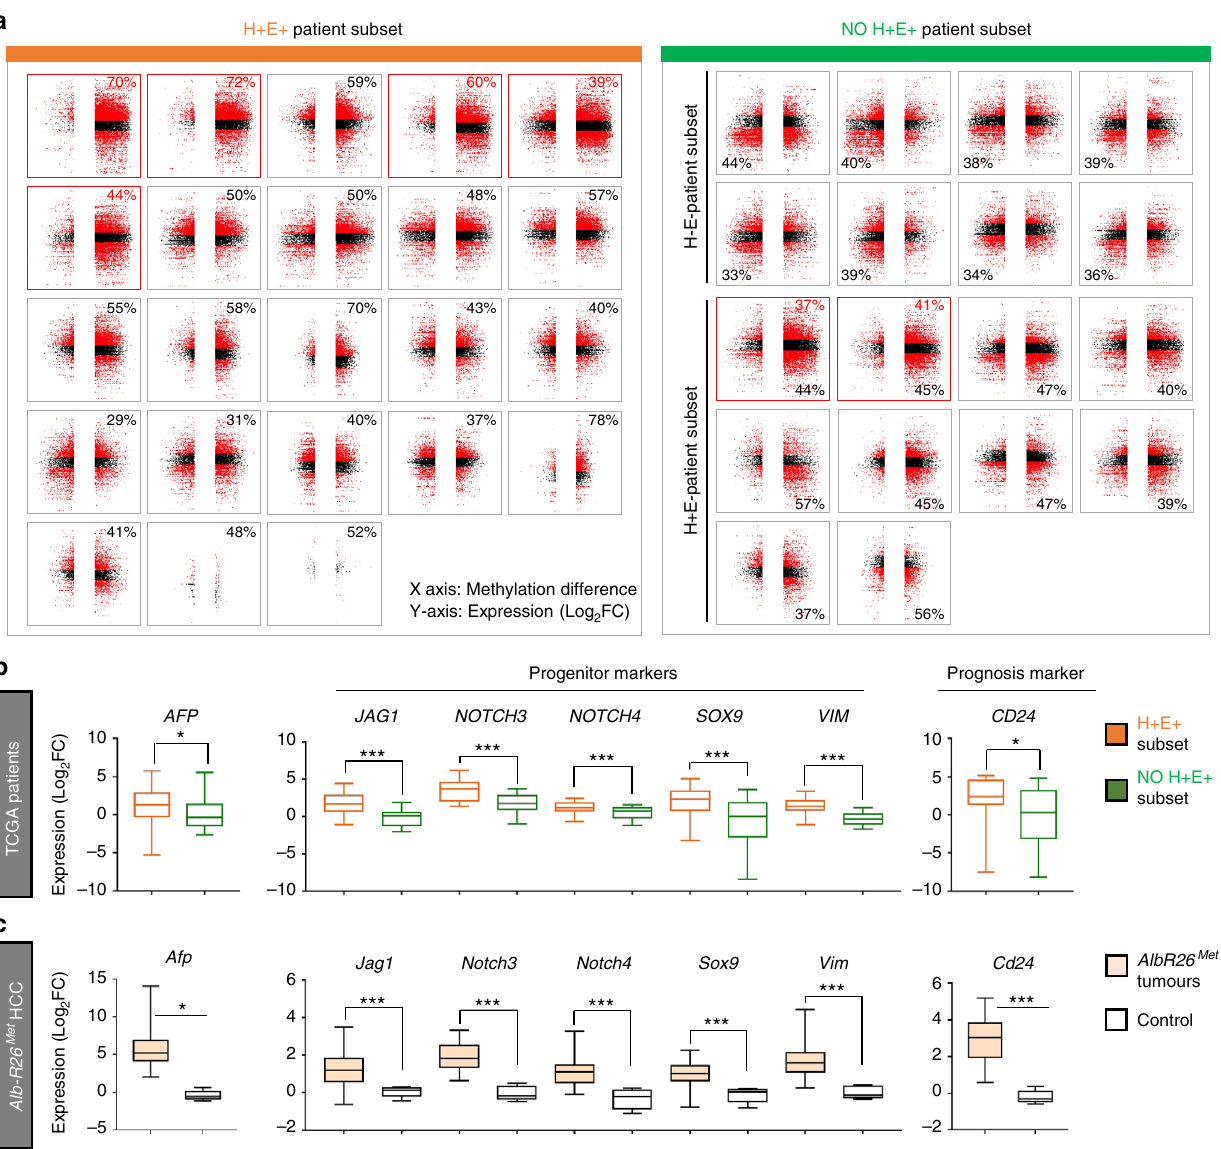
Fig. 5 A HCC patient subset, which is characterised by an enrichment of genes overexpressed and with hypermethylated CGIs, belongs to the HCC “ proliferative-progenitor ” subclass. a The 41 HCC patients are classi fi ed according to the highest percentage of genes over- versus underexpressed and with hyper- versus hypomethylated CGIs. In orange (left), patients with an enrichment of genes overexpressed and with CGI hypermethylation (H + E + patient subset). Patients are organised according to the absolute number of hypermethylated CGIs. The percentage of genes overexpressed and hypermethylated is reported on the top. In green (right), all other patients are reported (NO H + E + patient subset). Note that this patient subset is characterised by an enrichment in downregulated genes. Patients are organised according to an enrichment of genes with CGI hypomethylation (top) and hypermethylation (bottom). Concerning the 7 patients of the HCC subgroup 3 identi fi ed in Fig. 1f (corresponding to the best overlap patients), 5 of them belong to the H + E + subset. Notably, all of these 7 patients are characterised by more than 37% of genes both hypermethylated and overexpressed (highlighted in panel with a red square and a red percentage of genes overexpressed with hypermethylated CGI). The X -axis reports methylation differences, whereas the Y -axis reports expression as Log 2 FC. b Transcript levels (from RNA-seq data) of the indicated genes in H + E + patient subset (in orange) versus the others (in green). Note signi fi cant high transcript levels of AFP, JAG1, NOTCH3, NOTCH4, SOX9, VIM and CD24 in the H + E + patient subset. c Transcript levels by RT-qPCR for the same genes shown in b analysed in Alb-R26 Met tumours versus control livers, displaying the same pro fi le of gene upregulation as in the H + E + patient subset. Data have been reported in ref. 24 . Signi fi cance is indicated on the top. * P < 0.05, *** P < Mouse Cdkn2a has two CGIs: one in the promoter and another in hypermethylation of the gene body CGI (21/39 and 163/166, in the gene body. Instead, human CDKN2A has 5 CGIs: one in the the respective cohorts). In contrast, not methylation changes have promoter and four in the gene body. Data are available only for been detected in the promoter CGI for both HCC cohorts the CGI in the promoter and for one of the four CGIs located in gene body. Notably, in both cohorts we found an enrichment of patients with an overexpression of CDKN2A (39/41 and 166/204, in the respective cohorts), which is associated to a